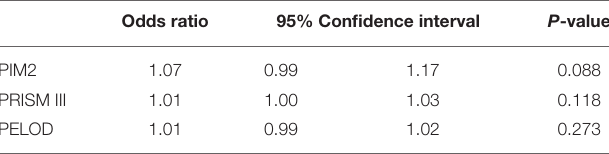
TABLE 3 | Logistic regression and odds of mortality.